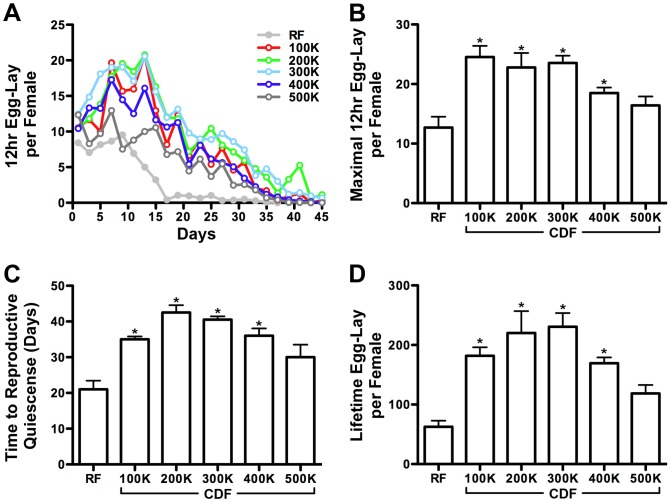
The effect of CDF on adult female egg-laying.Chemically defined food extends the egg-laying ability of adult female flies. (A) Average egg-lay in 12 hours of adult female flies on chemically defined food as a function of caloric density. Females fed on CDF show an increase in both maximal egg-lay and reproductive lifespan (n = 4). B) Maximal 12-hour egg-lay on chemically defined food. CDF100K–400K enhances the maximal egg-laying ability compared to RF (Mann Whitney test; n = 4, p = 0.2454 for CDF500K and 0.0286 for others). (C) Number of days a female is capable of producing more than one egg per day. CDF100K–400K extends the reproductive lifespan compared to RF (Mann Whitney test; n = 4, p = 0.1441 for CDF500K and ≤0.0294 for others). (D) Total lifetime egg-lay per female on chemically defined food. Females lay more eggs on CDF100K–400K than on RF (Mann Whitney test; n = 4, p = 0.0571 for CDF500K and 0.0286 for others). See Table S3 for additional details.